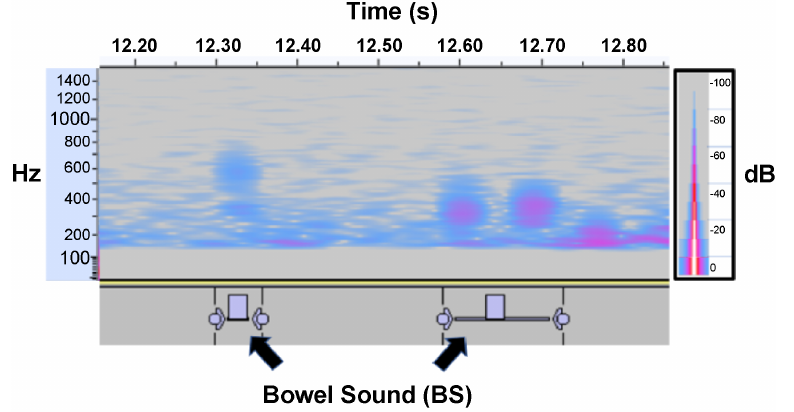
Figure 6. Spectrogram depicting bowel sounds recorded using the bottom microphone of a smartphone held in the right lower quadrant of the abdomen. Individual short BSs with multiple peaks are visible around the 100–800 Hz range.